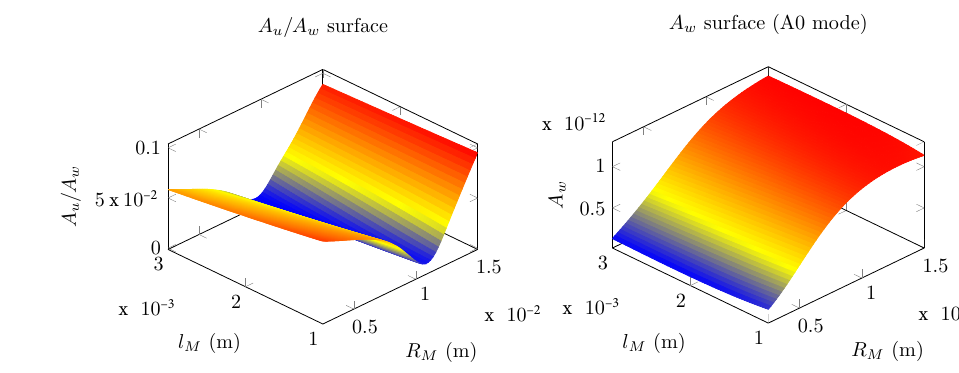
Figure 8. A u /A w and A w surfaces predicted with the MLP with basic BP algorithm.